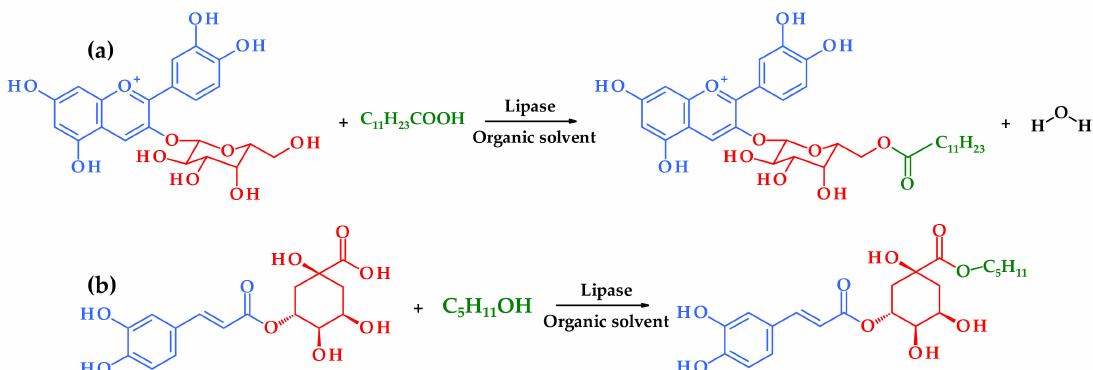
Figure 1. Enzymatic synthesis of ( a ) cyanidin-3- O -(6 (cid:48)(cid:48) -dodecanoyl)galactoside, and ( b ) pentyl chloro- genate. The phenolic moiety is highlighted in blue, sugar moiety and quinic acid are in red, and lipophilic molecules (fatty acid/alcohol) are marked in